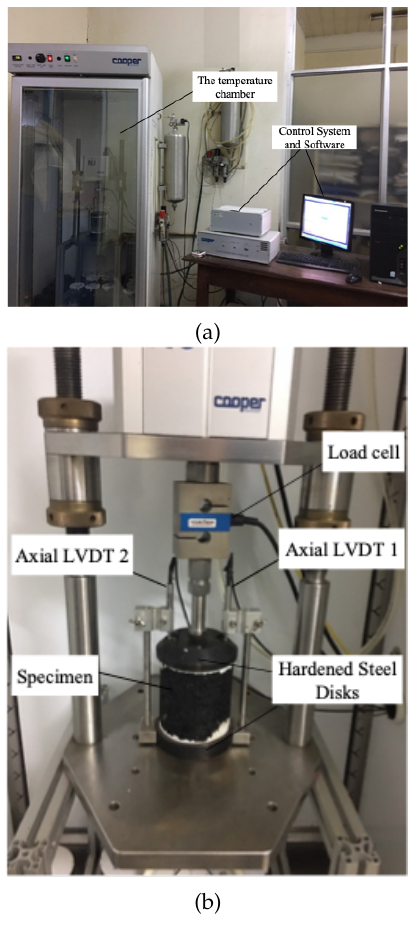
Fig. 3. Dynamic modulus test machine system: (a) The Fig. 2. Aging and compacting a) Aging mixtures in an temperature chamber, computer, software and control drying oven; b) Compacting mixtures by a gyratory system; (b) Dynamic modulus experimental compactor